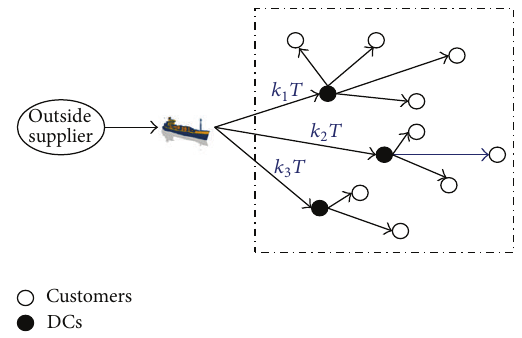
Figure 1: The three-level supply chain of proposed